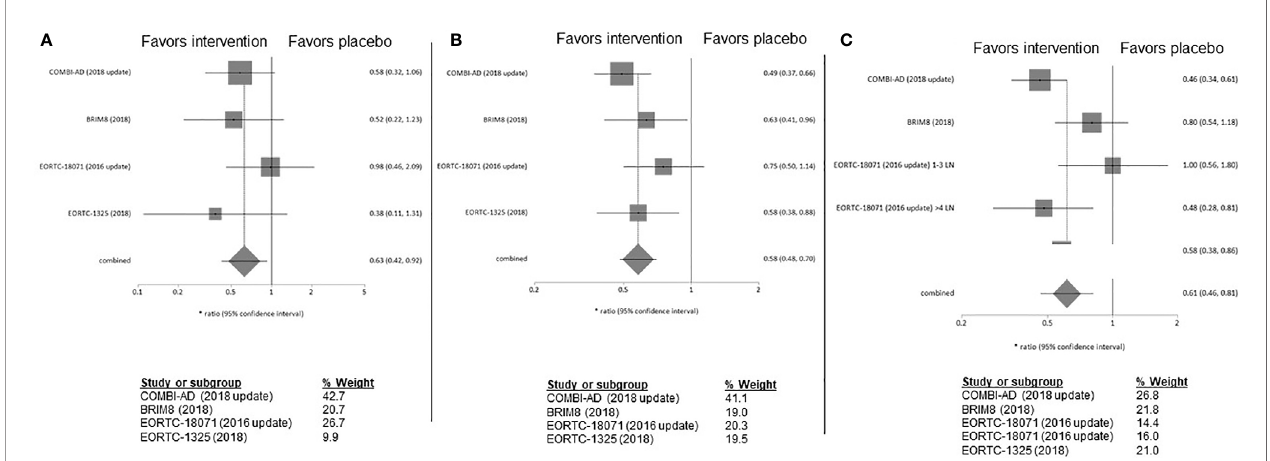
FIGURE 5 | (A) Forest plot for primary outcome analysis on relapse free survival for patients with stage IIIA ; (B) melanoma stage IIIB and C stage IIIC Hazard ratio for relapse or death along the x-axis, and results from all four studies; in (C) upper value for the EORTC18071 study includes patients in stage IIC with 1 – 3 LN, lower value with 4 LN, with gray squares representing effect estimates and lines through them representing 95% CIs. The gray diamond represents the overall effect measure which lies clear of the line off no effect, showing a bene fi t for the treatment groups compared to placebo. The percentage weight for each study is separately listed underneath the graph. CI, con fi dence interval; LN, lymph